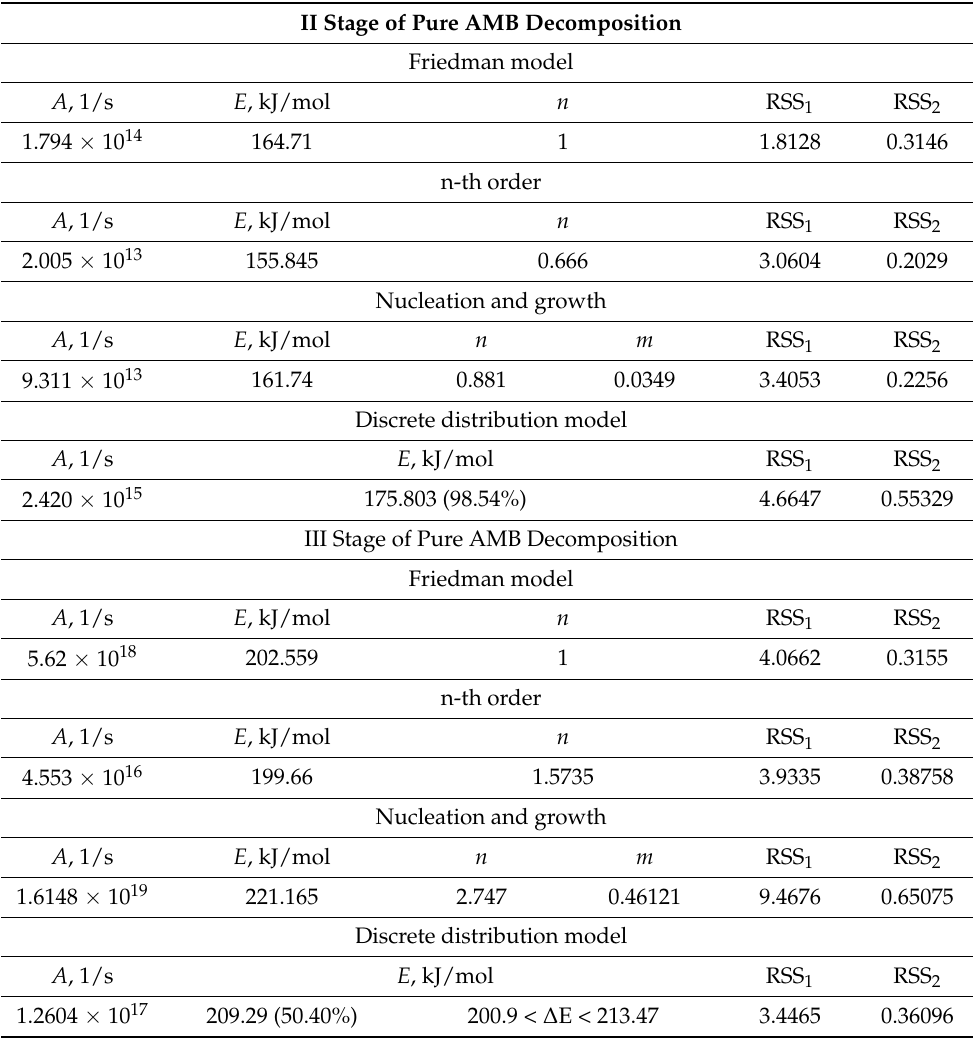
Table 2. The isoconversional and model-fitting kinetic analysis of AMB thermal decomposition: II stage (upper/first table) and III stage (down/second